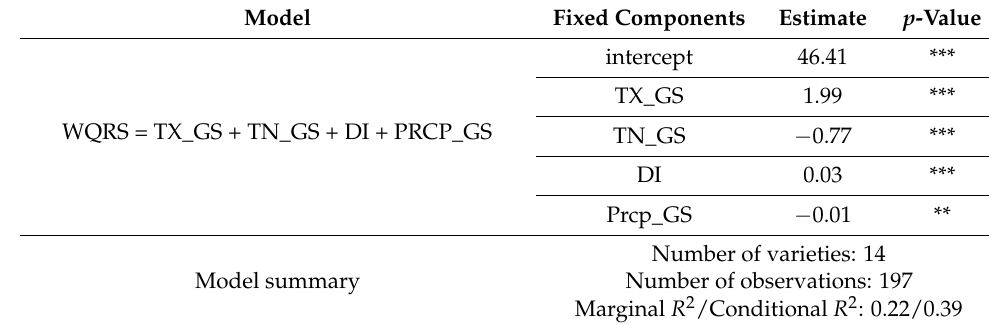
Table 5. Results of mixed-effects model analysis of Greek wine quality ratings with climate. Model Fixed Components Estimate p -Value